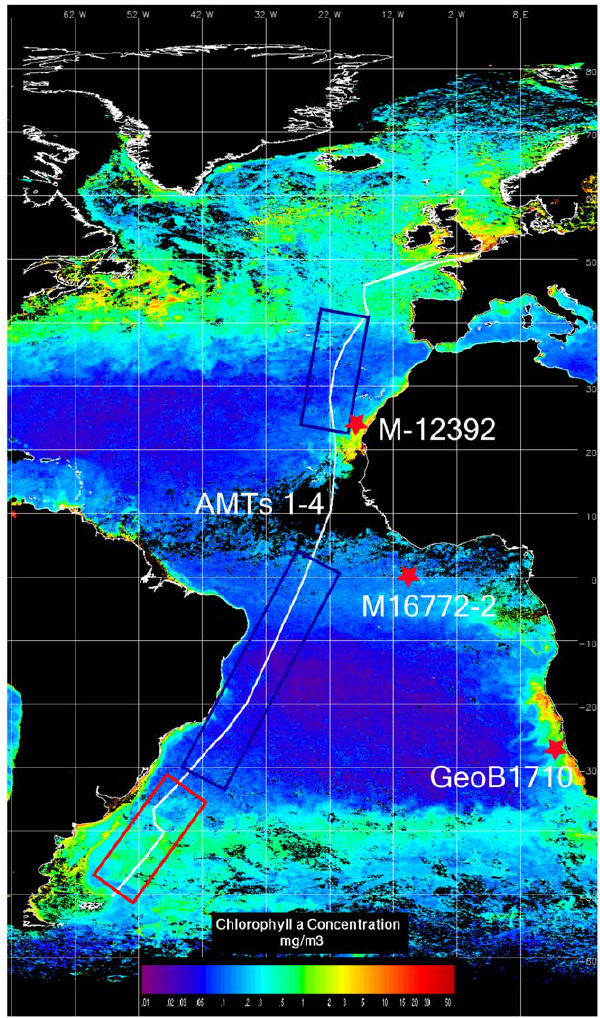
Figure 1. Map showing the sampling sites overlain on a satellite image of ocean color. Atlantic Meridional Transect tracks (white line) separated into subtropical regions (blue boxes) and the sub- Antarctic front (red box), and sediment core sampling sites (red stars).